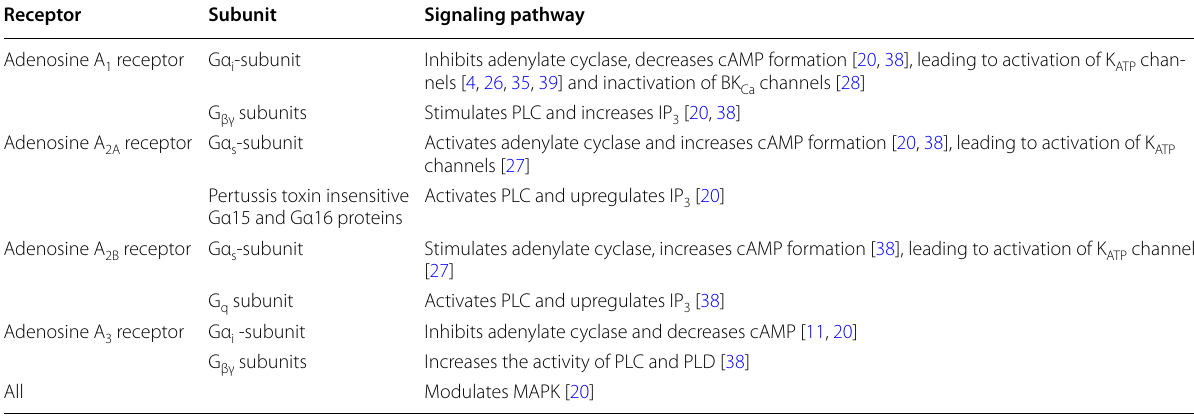
cAMP cyclic adenosine monophosphate, IP 3 inositol 1,4,5-triphosphate, MAPK mitogen-activated protein kinase, PLC phospholipase C, PLD phospholipase D